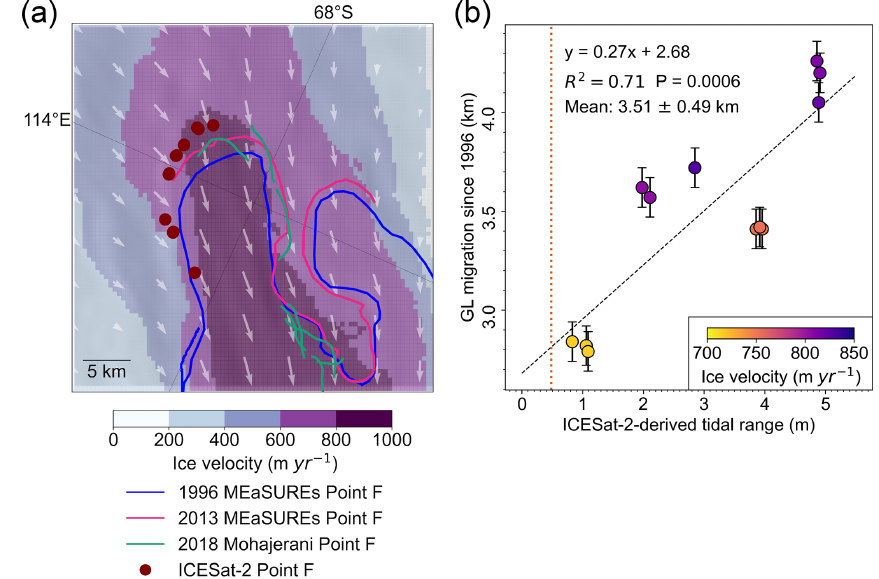
Figure 5. (a) Grounding line (GL) distributions at the main glacier trunk of the Totten Glacier Ice Shelf (TGIS) overlaid with the ice surface velocity magnitudes (Rignot et al., 2017) and ice flow directions (white arrows). The ICESat-2-derived Point F locations are shown as maroon dots. The 1996 and 2013 DInSAR-derived GLs (Rignot et al., 2011, 2016) are shown as blue and pink solid lines, respectively. The 2018 DInSAR-derived GLs (Mohajerani et al., 2021) are shown as green solid lines. (b) The ICESat-2-derived tidal range for each Point F at the selected ice flowlines in Fig. S2b, and the GL migration distance between DInSAR-derived GL in 1996 (Rignot et al., 2011, 2016) and ICESat-2-derived Point F along ice flowlines (Table S4). The vertical orange dotted line denotes the tidal range calculated from the CATS2008 tidal model at the time of the satellite passes used in MEaSUREs 1996 ERS-1/2 DInSAR grounding line measurement (Rignot et al., 2011, 2016) (Table